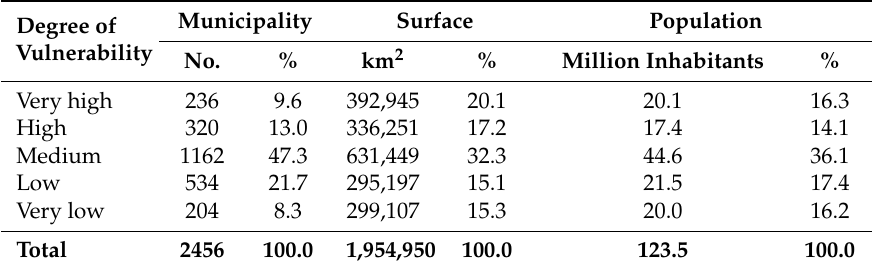
Figure 6. Map of economic vulnerability to drought. Table 10. Distribution of number of municipalities, surface area, and population by degree of economic vulnerability to drought.